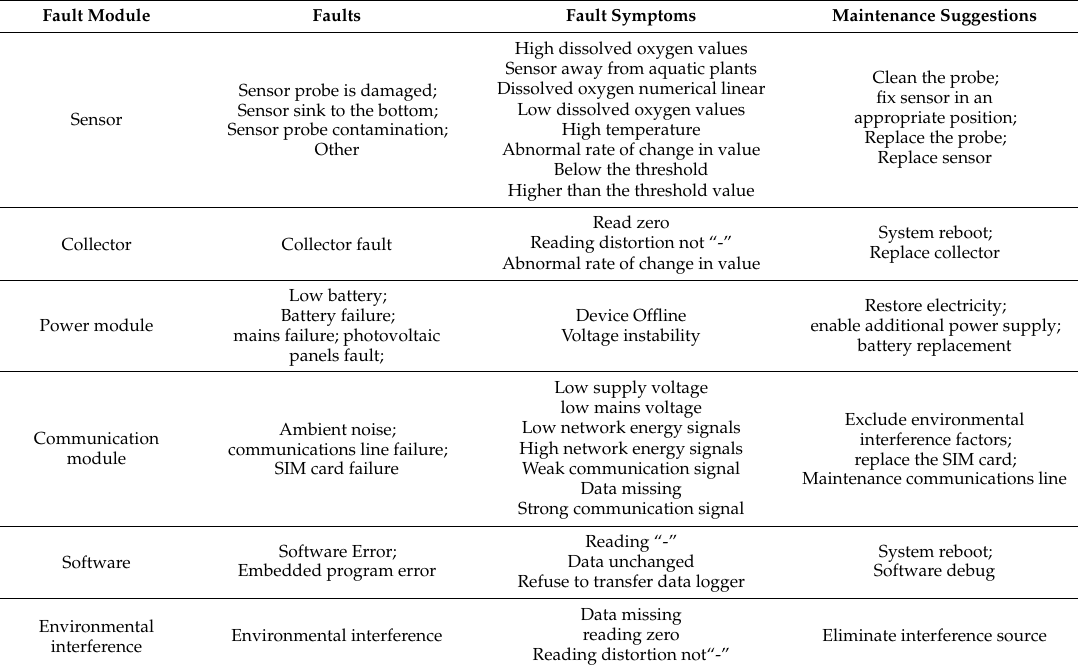
Table 1. The fault patterns in the aquaculture IoT.